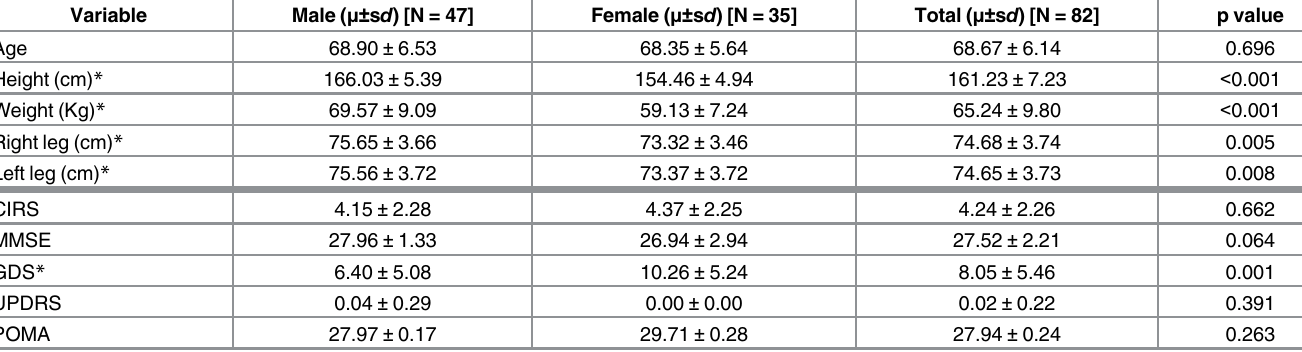
Table 1. Subject